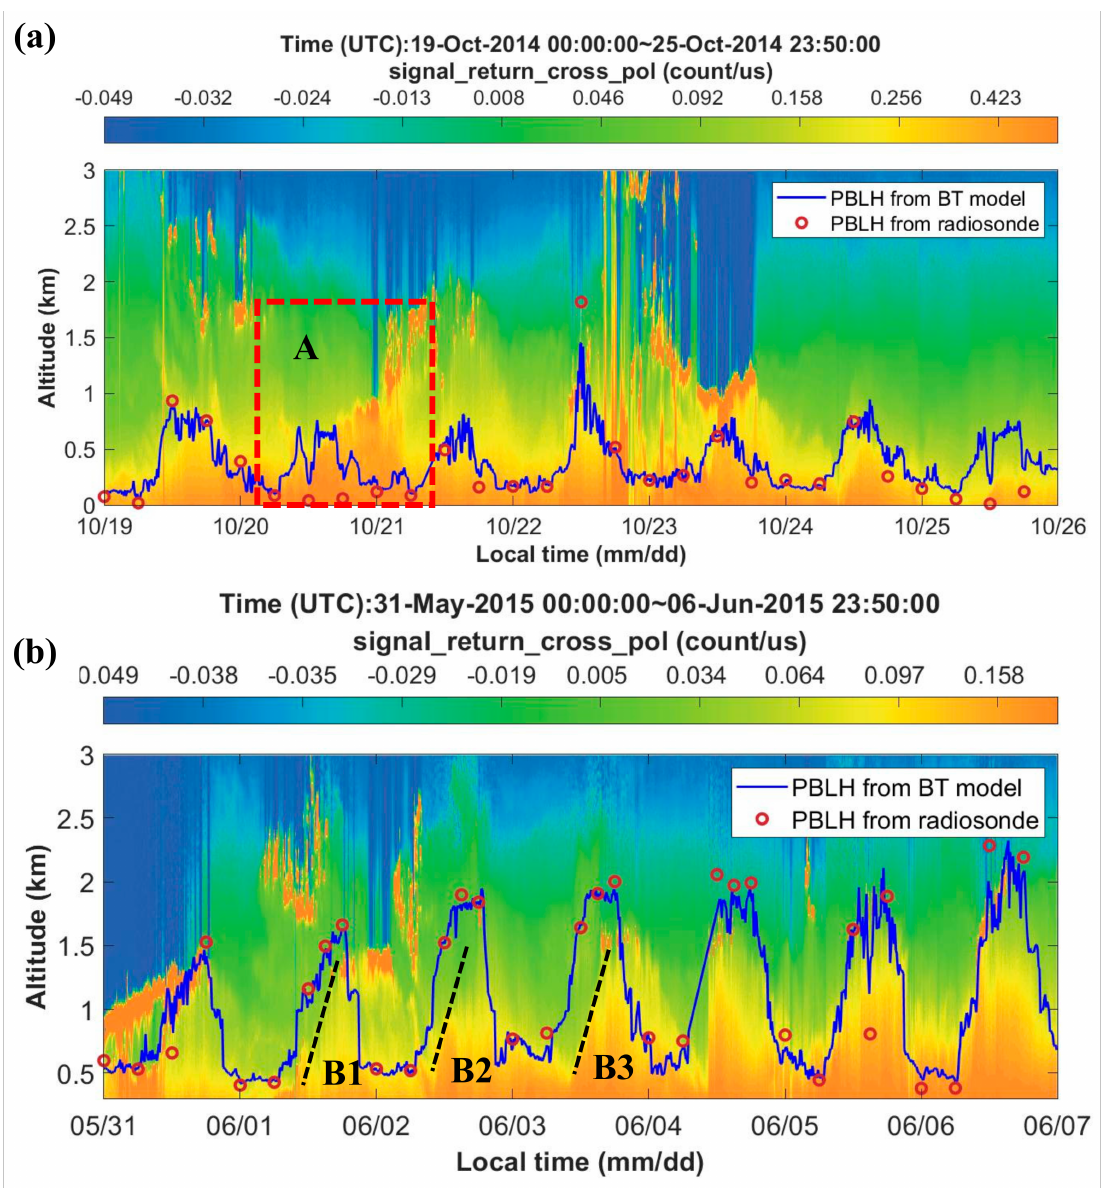
Figure 8. MPL signal measured from ( a ) 19 October 2014 to 25 October 2014 and ( b ) 31 May 2015 to 6 June 2015; PBLHs were determined with the BT model (blue line) and radiosonde (red